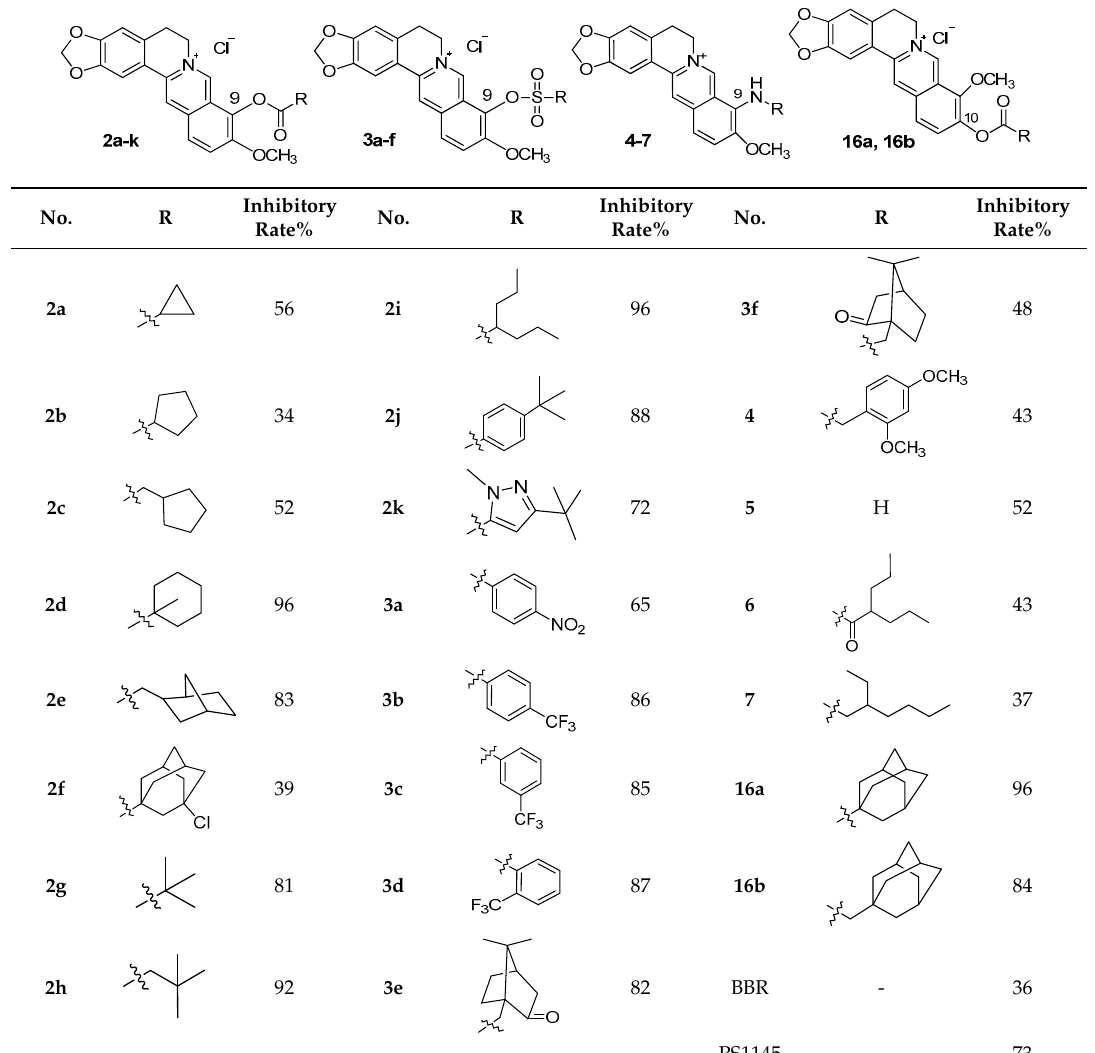
Molecules 2017 , 22 , 1257 Table 1. Structures and inhibition effect of target compounds on tumor necrosis factor Table 1. Structures and inhibition effect of target compounds on tumor necrosis factor (TNF)-induced Molecules 2017 , 22 , 1257 (TNF)-induced nuclear factor (NF)- κ B activities. nuclear factor (NF)- κ B activities. Table 1. Structures and inhibition effect of target compounds on tumor necrosis factor Table 1. Structures and inhibition effect of target compounds on tumor necrosis factor Table 1. Structures and inhibition effect of target compounds on tumor necrosis factor Table 1. Structures and inhibition effect of target compounds on tumor necrosis factor Table 1. Structures and inhibition effect of target compounds on tumor necrosis factor Table 1. Structures and inhibition effect of target compounds on tumor necrosis factor Table 1. Structures and inhibition effect of target compounds on tumor necrosis factor Table 1. Structures and inhibition effect of target compounds on tumor necrosis factor Table 1. Structures and inhibition effect of target compounds on tumor necrosis factor Table 1. Structures and inhibition effect of target compounds on tumor necrosis factor Table 1. Structures and inhibition effect of target compounds on tumor necrosis factor Table 1. Structures and inhibition effect of target compounds on tumor necrosis factor Table 1. Structures and inhibition effect of target compounds on tumor necrosis factor (TNF)-induced nuclear factor (NF)- κ B activities. (TNF)-induced nuclear factor (NF)- κ B activities. (TNF)-induced nuclear factor (NF)- κ B activities. Table 1. Structures and inhibition effect of target compounds on tumor necrosis factor (TNF)-induced nuclear factor (NF)- κ B activities. (TNF)-induced nuclear factor (NF)- κ B activities. (TNF)-induced nuclear factor (NF)- κ B activities. Table 1. Structures and inhibition effect of target compounds on tumor necrosis factor Table 1. Structures and inhibition effect of target compounds on tumor necrosis factor Table 1. Structures and inhibition effect of target compounds on tumor necrosis factor (TNF)-induced nuclear factor (NF)- κ B activities. Table 1. Structures and inhibition effect of target compounds on tumor necrosis factor Table 1. Structures and inhibition effect of target compounds on tumor necrosis factor Table 1. Structures and inhibition effect of target compounds on tumor necrosis factor (TNF)-induced nuclear factor (NF)- κ B activities. (TNF)-induced nuclear factor (NF)- κ B activities. (TNF)-induced nuclear factor (NF)- κ B activities. (TNF)-induced nuclear factor (NF)- κ B activities. Table 1. Structures and inhibition effect of target compounds on tumor necrosis factor Table 1. Structures and inhibition effect of target compounds on tumor necrosis factor (TNF)-induced nuclear factor (NF)- κ B activities. (TNF)-induced nuclear factor (NF)- κ B activities. (TNF)-induced nuclear factor (NF)- κ B activities. (TNF)-induced nuclear factor (NF)- κ B activities. (TNF)-induced nuclear factor (NF)- κ B activities. (TNF)-induced nuclear factor (NF)- κ B activities. (TNF)-induced nuclear factor (NF)- κ B activities. (TNF)-induced nuclear factor (NF)- κ B activities. (TNF)-induced nuclear factor (NF)- κ B activities. (TNF)-induced nuclear factor (NF)- κ B (TNF)-induced nuclear factor (NF)- κ B activities.